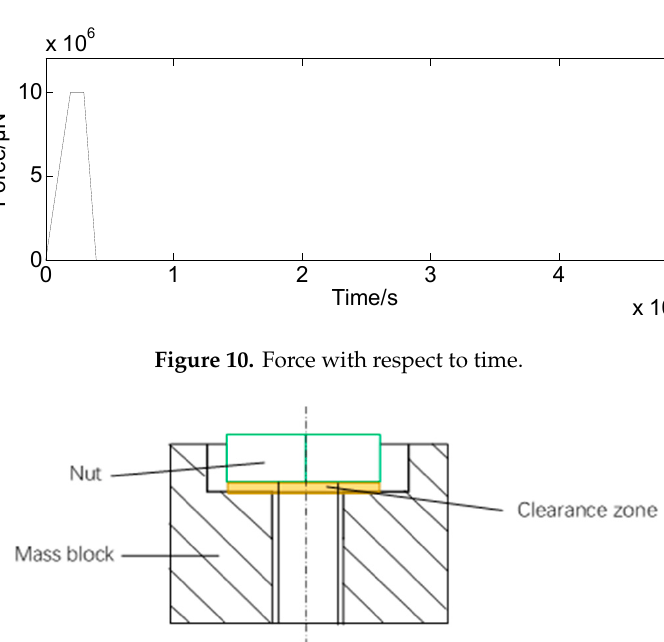
Figure 12. Damping with respect to time.